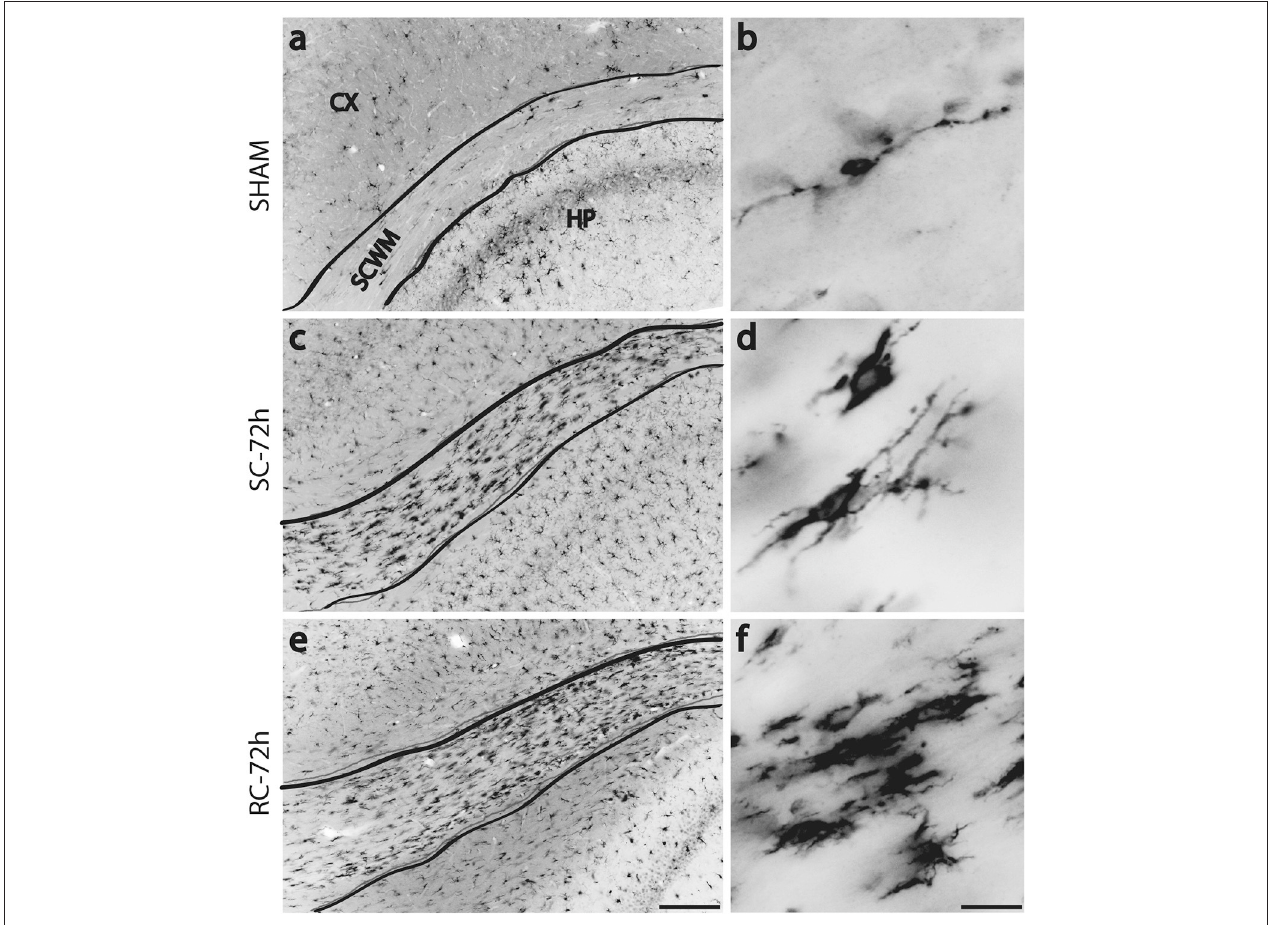
FIGURE 3 | Changes in Iba-1 immunoreactivity in sub cortical white matter (SCWM) at 72h post injury. Few scattered microglia with migrating morphology (long processes) were found in sham rat’s SCWM (a,b) . Numerous, hypertrophied microglia were found in the SCWM following either single (c,d) or repeated concussions (e,f) . SC: single concussion, RC: repeated concussion, CX: cortex, HP: hippocampus, SCWM: subcortical white matter. Scale bar in e (for left panel) = 200 µ m and in f (for right panel) = 50 µ m.